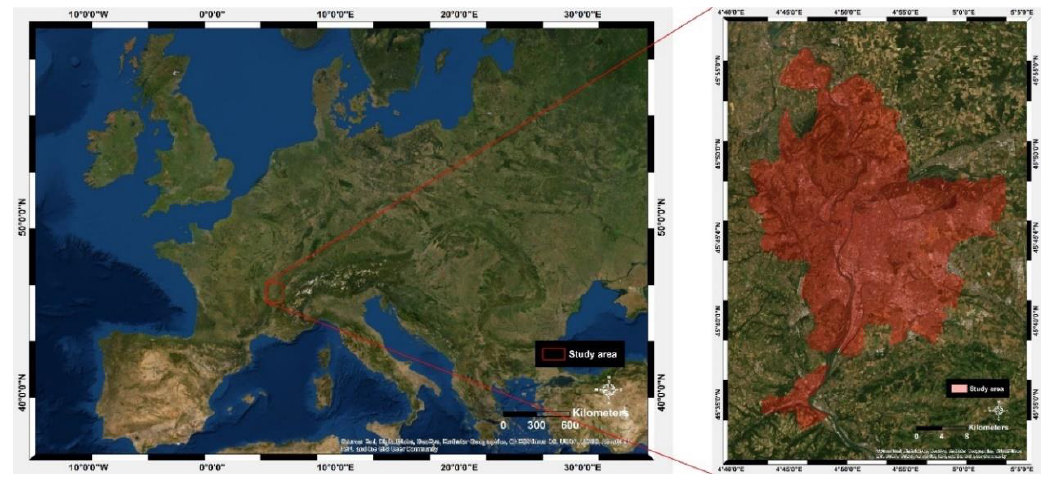
Figure 2. Location of the Metropolis of the Greater Lyon area (source ESRI).